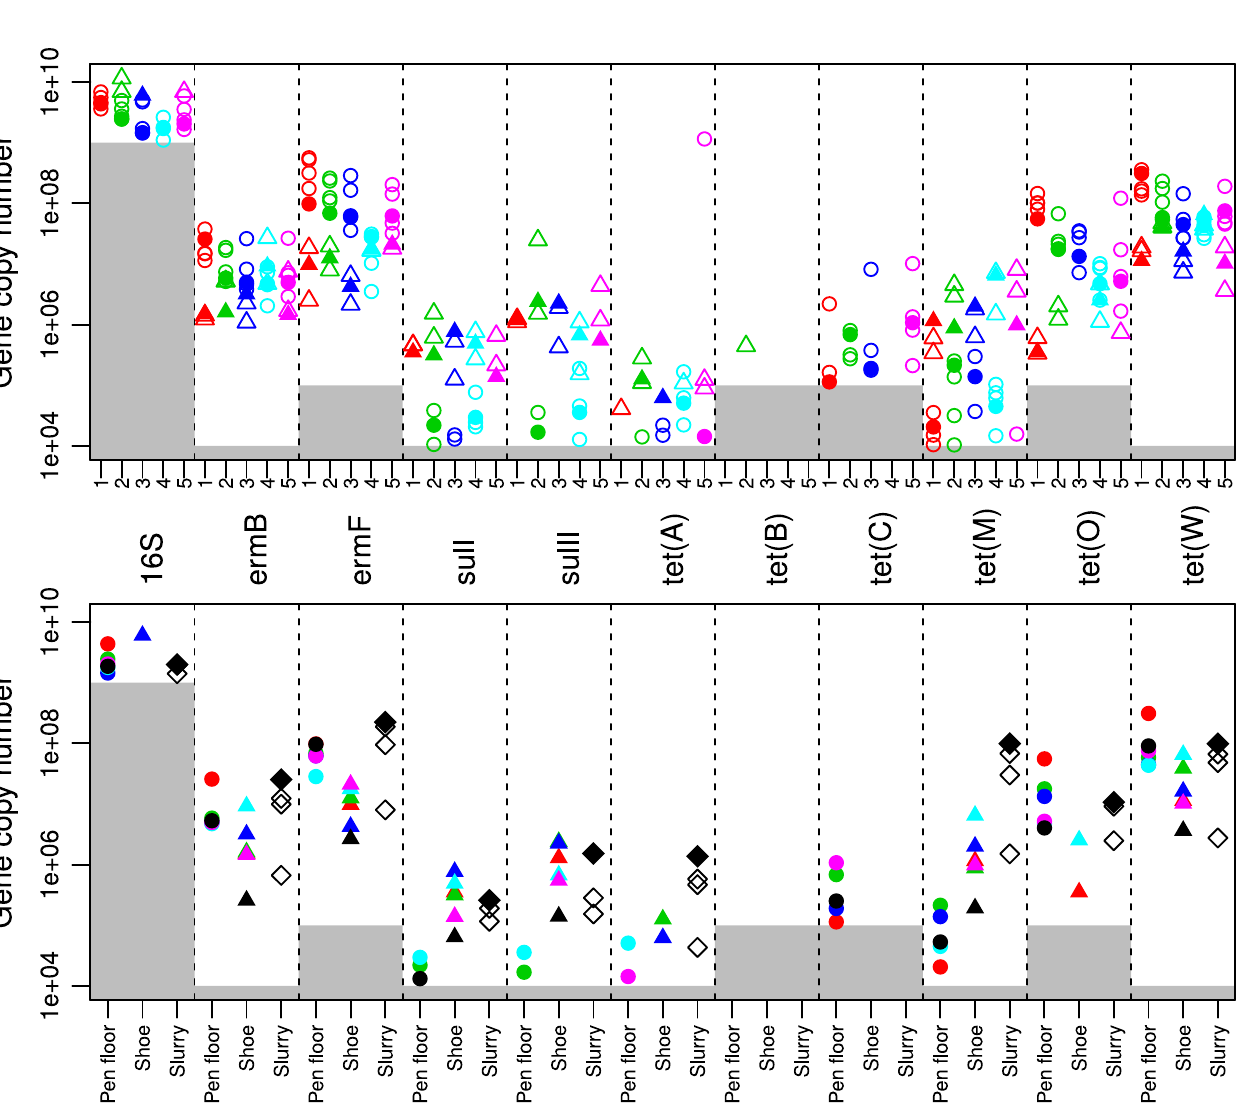
Fig 4. Sampling 2 gene copy numbers g -1 feces in sections 1 – 5. Top: Copy numbers of genes g -1 feces above the limit of quantification, LOQ (grey area = below LOQ) for pen floor samples (circles) and shoe cover samples (triangles) within sections 1 – 5 in sampling 2 (section 1, red; section 2, green; section 3, purple; section 4, blue; section 5, pink). The laboratory pooled samples are included for each section in their respective color (pen floor pool stable, solid circle; shoe cover pool stable, solid triangles). Each column represents a denoted gene (the respective genes are depicted in the middle of the figure and are shared for the top and bottom section of Fig 4). Bottom: Copy numbers of genes g -1 feces above the LOQ (LOQ = grey area) for pen floor pool stable samples (solid circles); shoe cover pool stable samples (solid triangles) for stables 1 – 5 (stable 1, red; stable 2, green; stable 3, purple; stable 4, blue; stable 5, pink); Slurry samples 1 – 3 (white diamond); Pen floor pool herd samples (black solid circle); Shoe cover pool herd sample (black solid triangle); Pool slurry (black solid diamond). The sampling methods are given under the bottom figure (Pen floor = pen floor pool herd; Shoe = shoe cover pool herd; Slurry